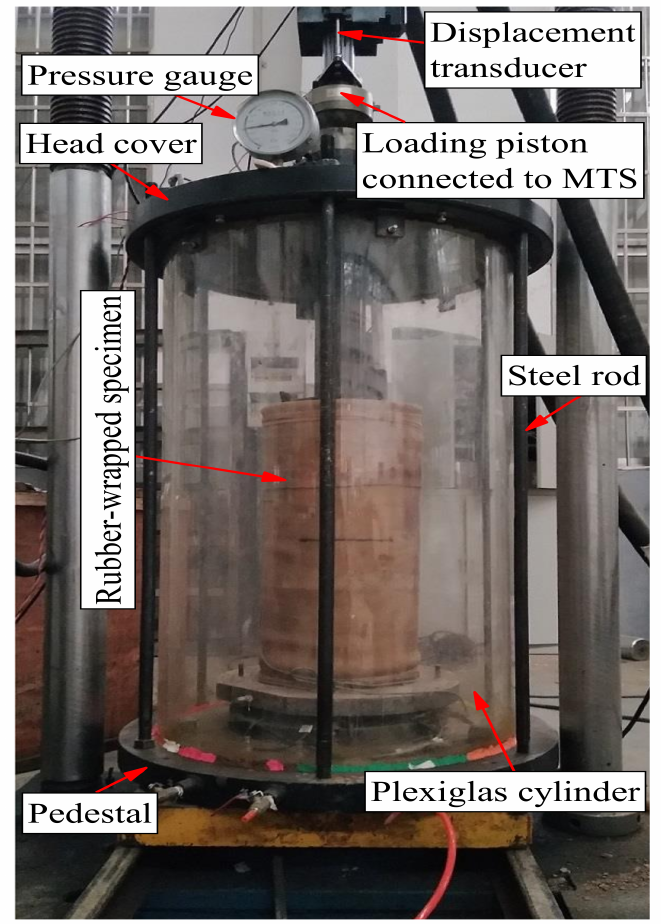
Figure 3. Photograph of the test device